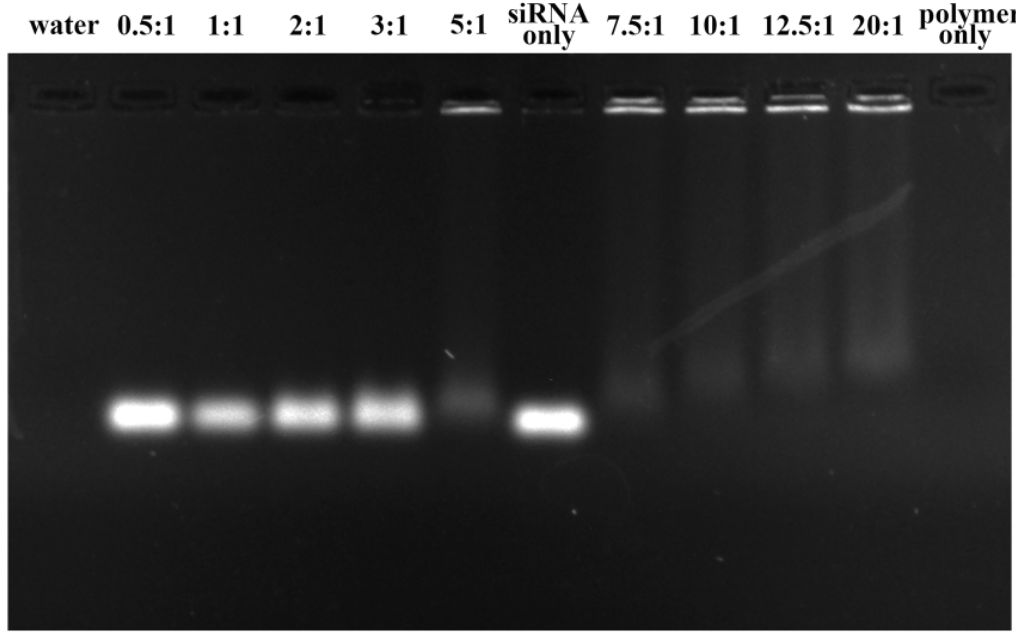
Figure 3. Agarose gel electrophoresis of PEI-PLA@siRNA polyplex at various N / P ratios.